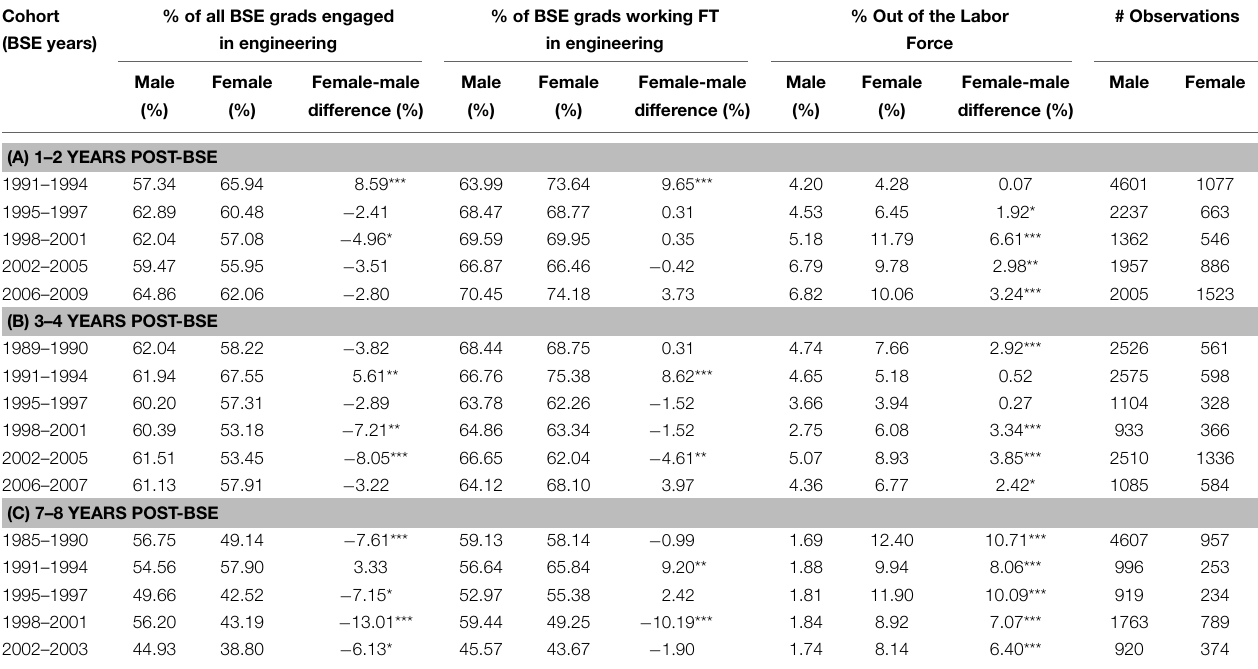
TABLE 3 | Average probability of remaining in engineering (working or studying) or out of the labor force by BSE year cohort. Cohort % of all BSE grads engaged % of BSE grads working